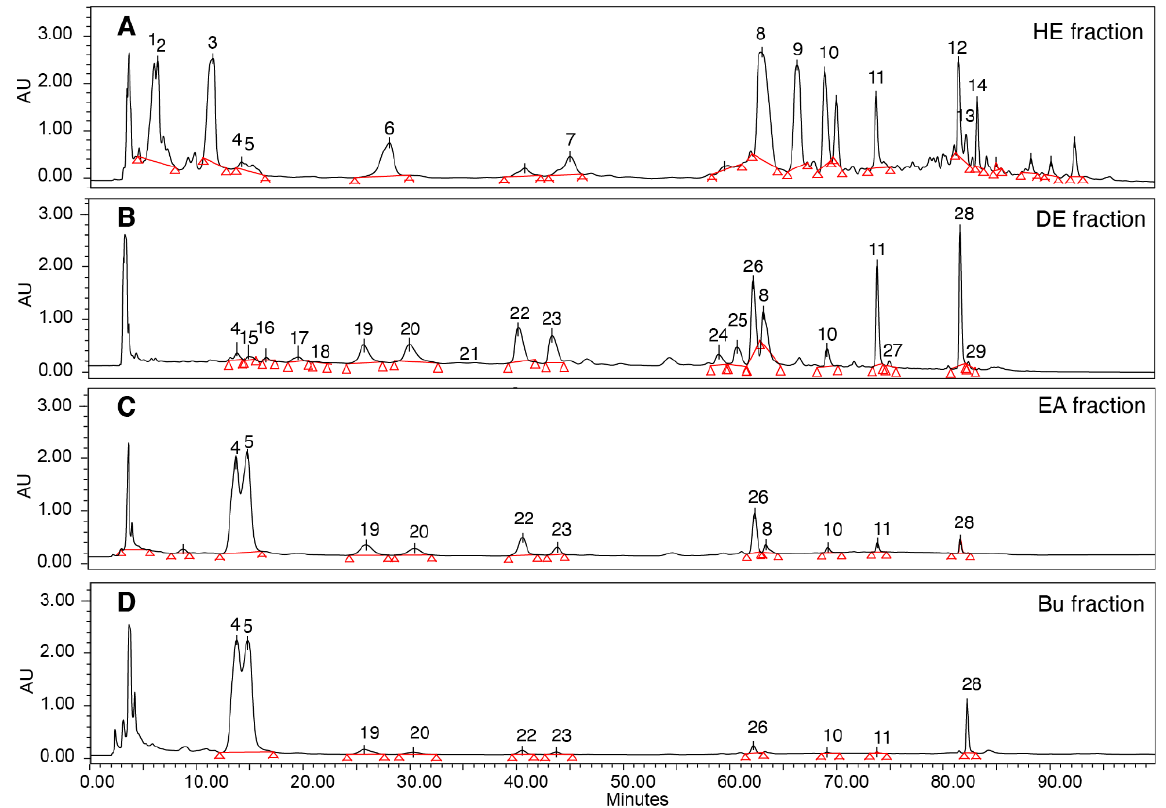
Figure 2. HPLC profiling and bioactivities of Antrodia cinnamomea fruiting bodies from different fractions. ( A ) Hexane; ( B ) diethyl ether; ( C ) ethyl acetate; and ( D ) n-butanol fractions. (HE: hexane; DE: diethyl ether; EA: ethyl acetate; Bu: n-BuOH).